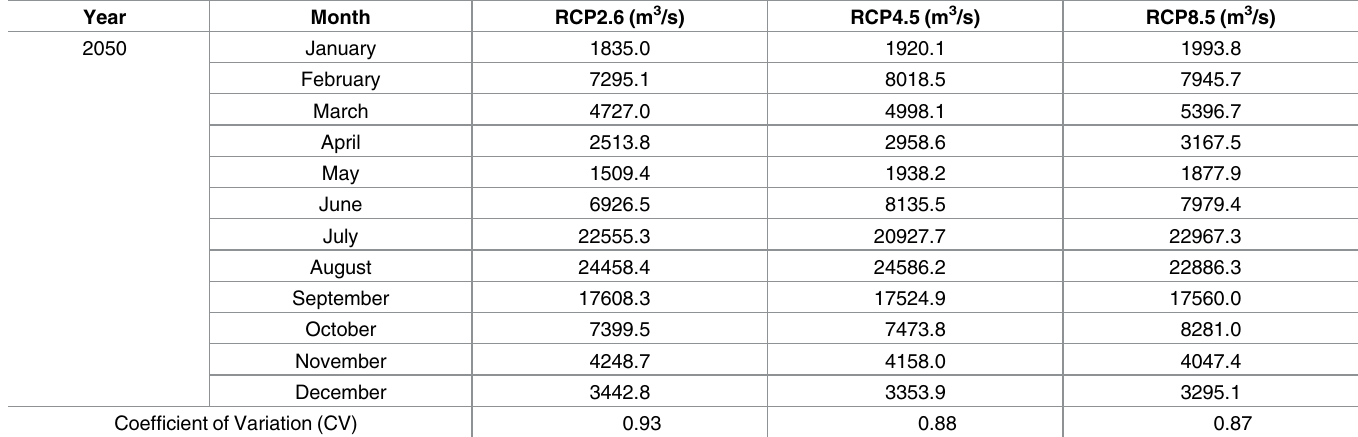
Table 5. Monthly streamflow simulations using MS-DTVGM under three RCP scenarios in 2050.